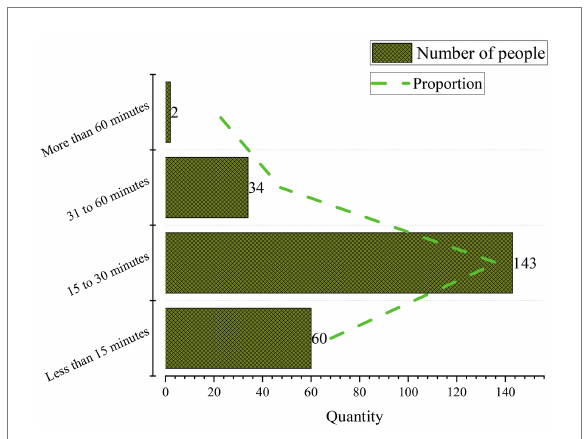
FIGURE 7 Time spent by college students learning English vocabulary.